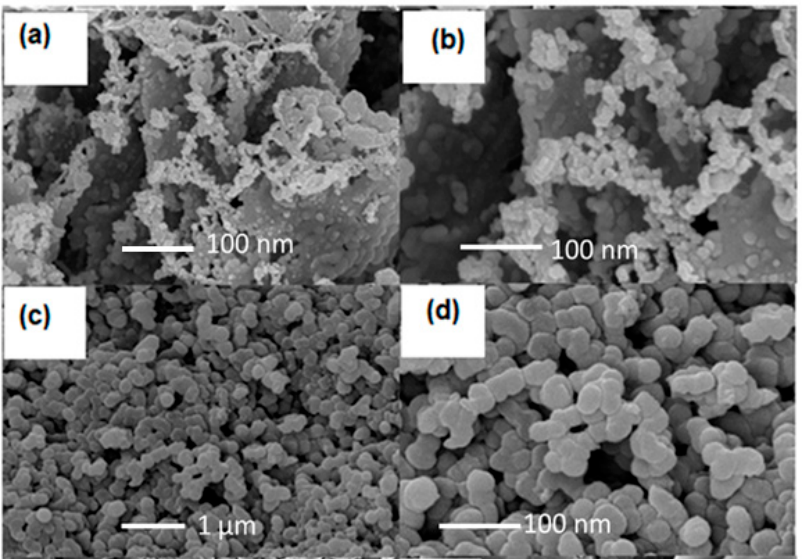
Figure 8. FESEM images of COF-S7 ( a , b ), at 100 × g and 50 × g magnifications, COF-S12 ( c , d ) at 25 × g and 50 × g magnifications under 5.0 kV accelerating voltage.